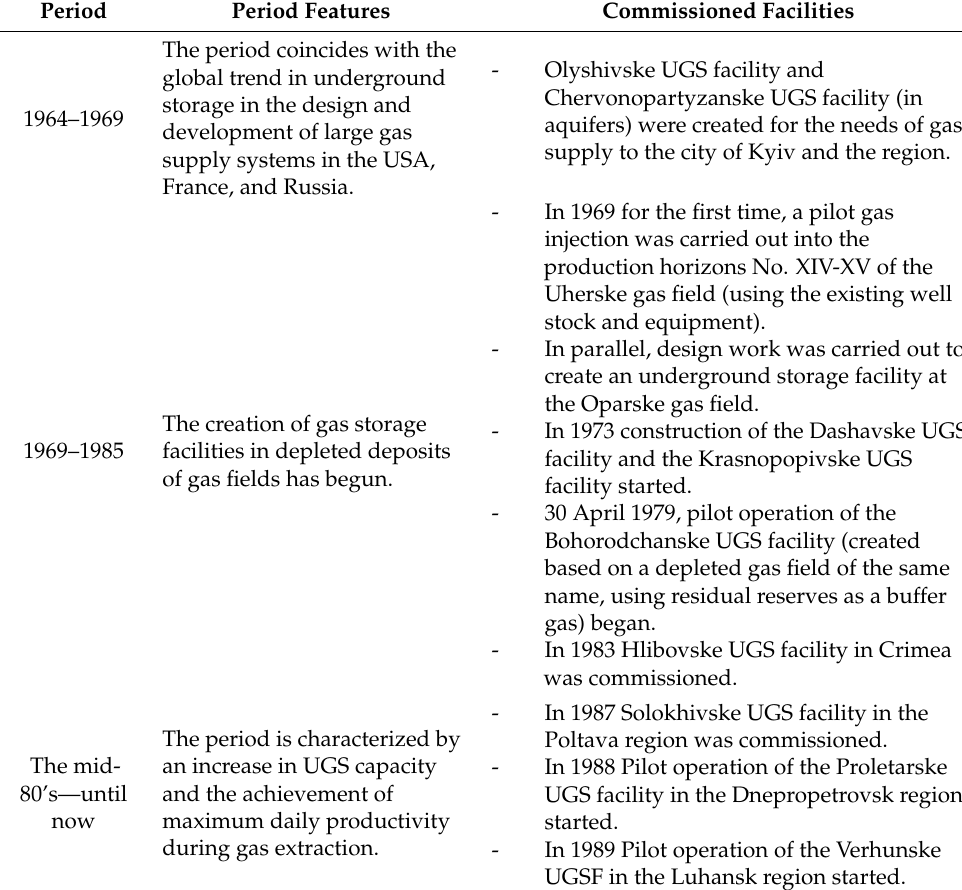
Table 1. Periods of development of underground gas storage in